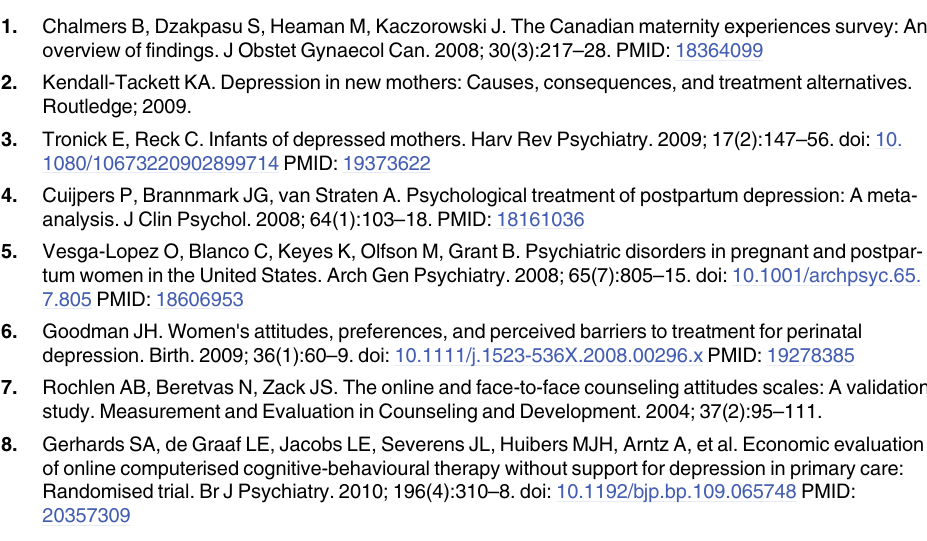
S1 Table. Demographic Characteristics by Group. S2 Table. Means and Standard Deviations for Primary and Secondary Outcomes. S3 Table. Regression Analyses of Secondary Outcome Variables. S4 Table. Descriptive Statistics for Program Engagement in the TA-ICBT condition ( N =